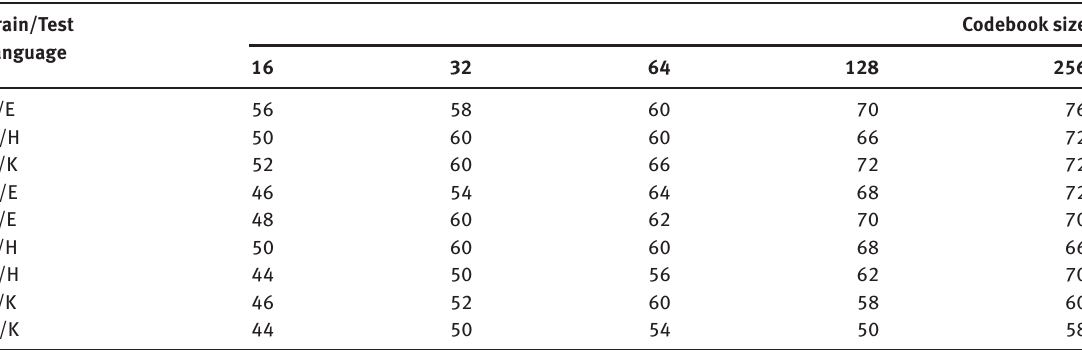
Table 2: Speaker Identification Performance (%) for the 50 Speakers of Our Own Database Using 20-s Training and Testing Data for the SOM Modeling Technique.